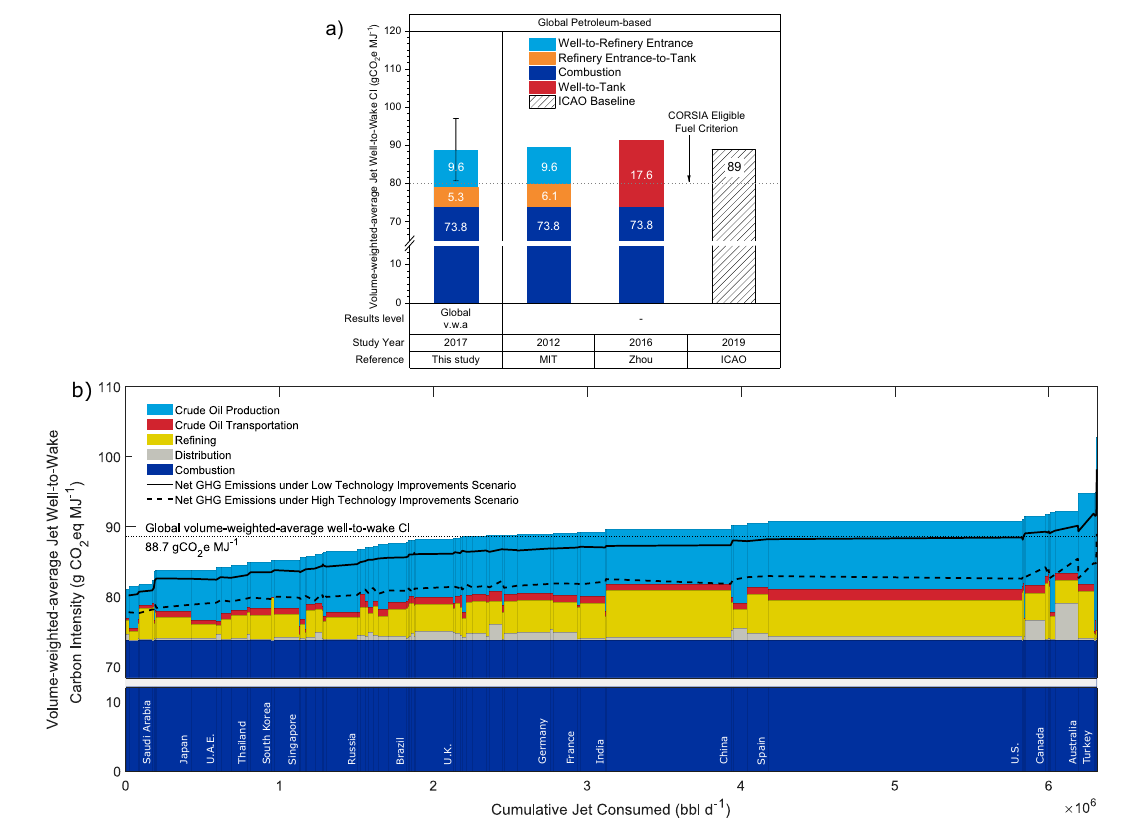
Fig. 2 | Well-to-wake carbon intensity of jet fuel. a Comparison between results obtained from this study and jet fuel well-to-wake CI values reported in the litera- ture. Well-to-re fi nery entrance includes crude oil production and transportation. Re fi nery entrance-to-tank includes re fi ning and distribution. Study year refers to the time period when data were collected (not the year the study was published). Global v.w.a. represents the global volume-weighted average CI (88.7 gCO 2 e MJ -1 ). Whiskers are 5 and 95 percentiles of the well-to-wake CI of jet fuel produced by re fi neries. See references forstudiesconductedby MIT 17 and Zhou et al 18 . and note that average combustion emissions are adjusted to 73.8 gCO 2 e MJ -1 for literature studiespresentedhere.Energy-basedprocessunit-levelbasedallocationisadopted for re fi ning in this study (see Methods). b 2017 country-level volume-weighted average jet fuel well-to-wake CI supply curve and emissions reduction